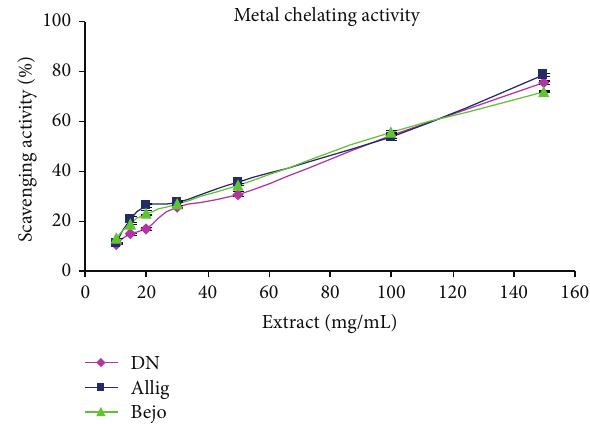
Figure 3: Effect of different concentrations on metal chelating activity in different date extracts: Allig, Bejo, and Deglet Nour (DN). Values are means of three replications ±